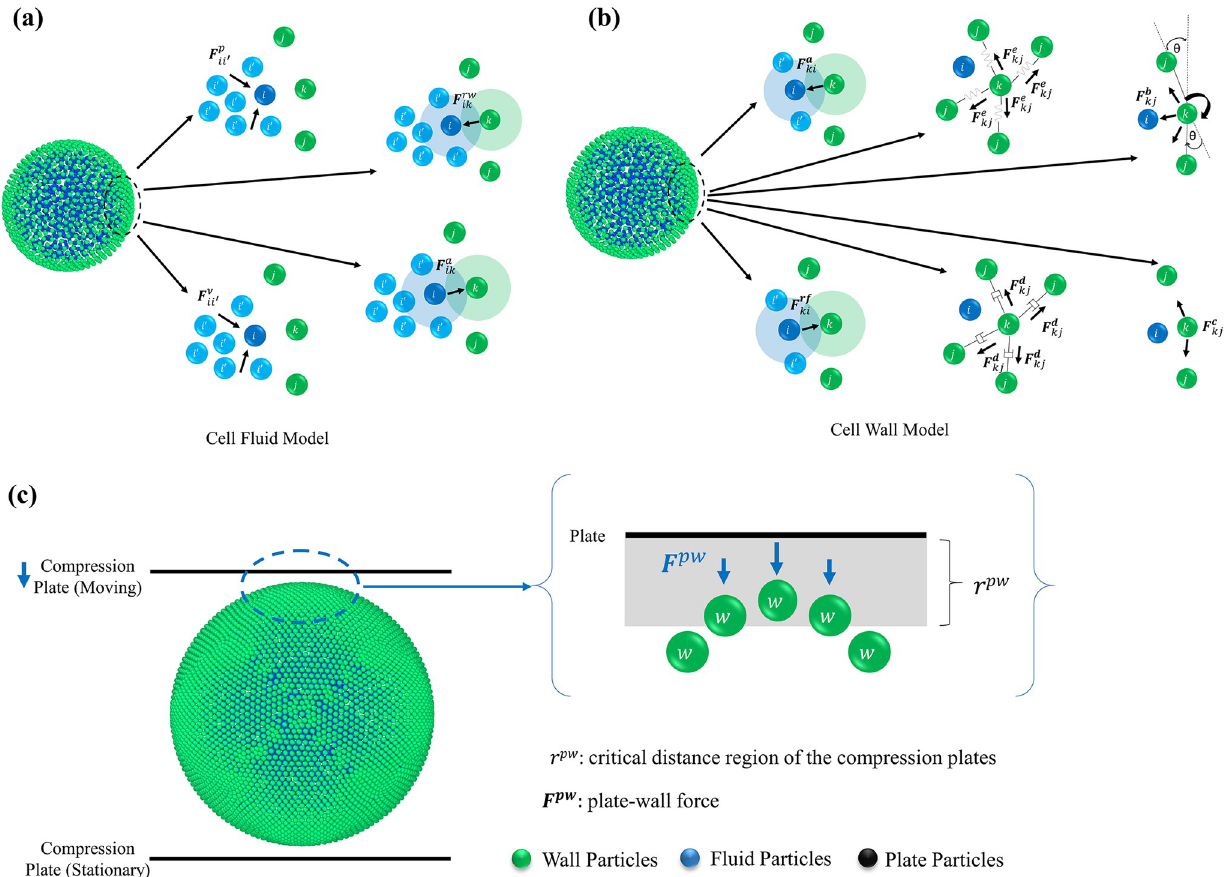
Fig 1. The graphical summary of the coupled Smoothed Particle Hydrodynamics (SPH) and Coarse-Grained (CG) computational model proposed for simulating plant cell compression during drying. (a) Force fields in the 3-D SPH fluid model: pressure forces ( F p ), viscous forces ( F v ), wall-fluid repulsion forces ( F rw ) and wall-fluid attraction forces ( F a ); (b) Force fields in the Coarse-Grained (CG) 3-D wall model: stiff forces ( F e ), damping forces ( F d ), wall-fluid repulsion forces ( F rf ), wall-fluid attraction forces ( F a ), bending stiffness forces ( F b ) and wall contraction forces ( F c ); (c) Implementation of cell compression in the SPH-CG model through interactions between the cell wall, cell fluid and the compression plates.